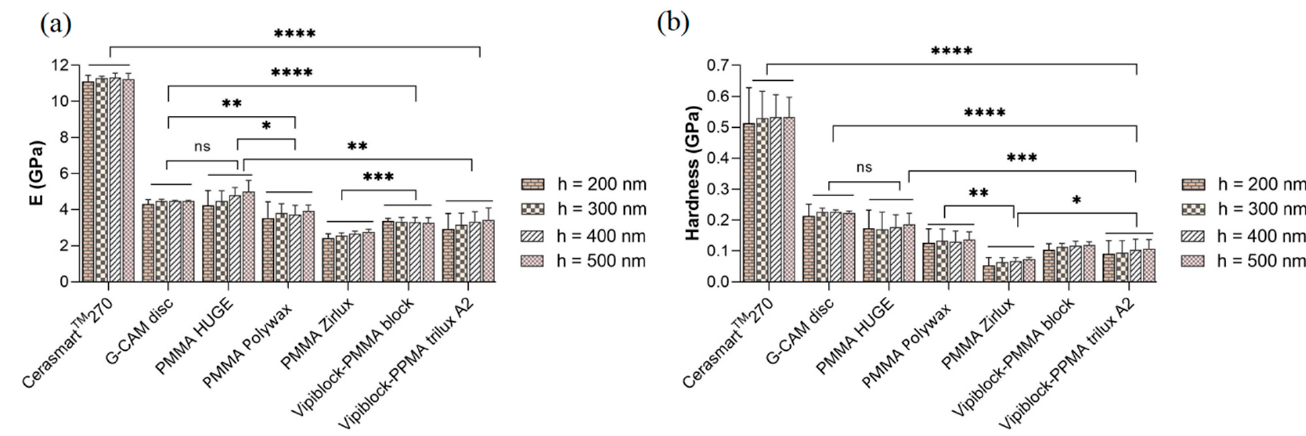
Figure 5. Representative variation of ( a ) micro-elastic modulus (E) and ( b ) micro-hardness (H) as function of indentation depth.